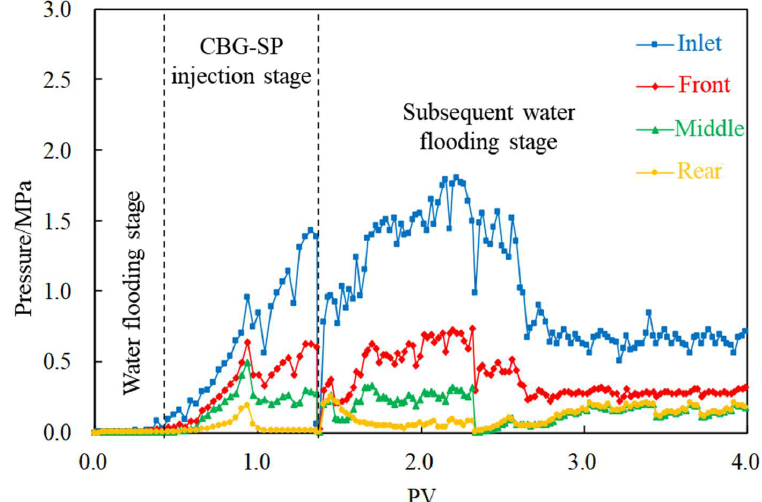
Figure 11. Typical displacement pressure change curve.